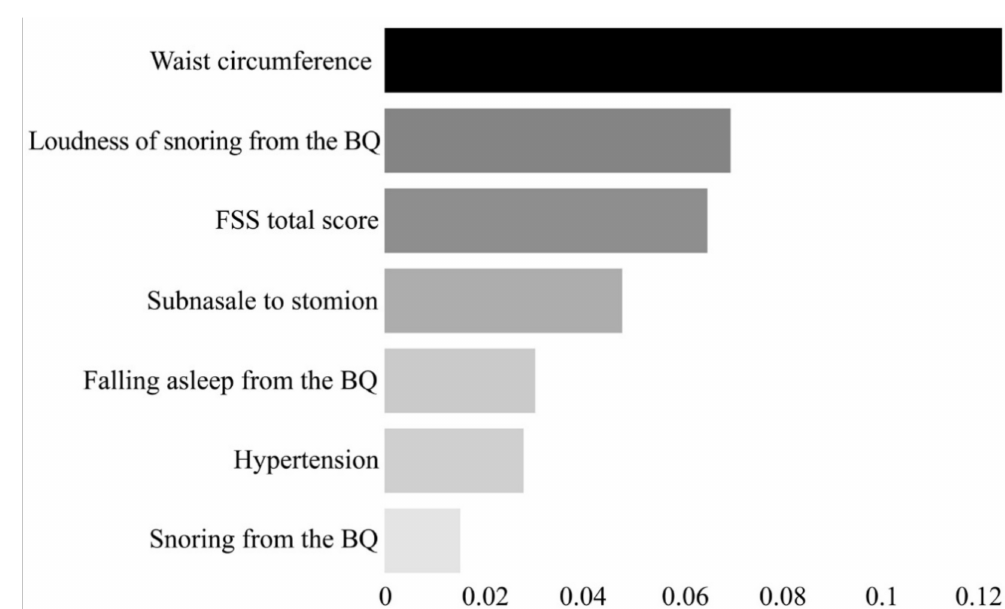
Figure 2. Feature importance plot for the seven final features selected through the permutation feature importance algorithm. The x-axis represents the importance of each feature. The scale of the x-axis is not absolute; it represents the magnitude of the relative importance. BQ, Berlin Questionnaire; FSS, Fatigue Severity Scale.